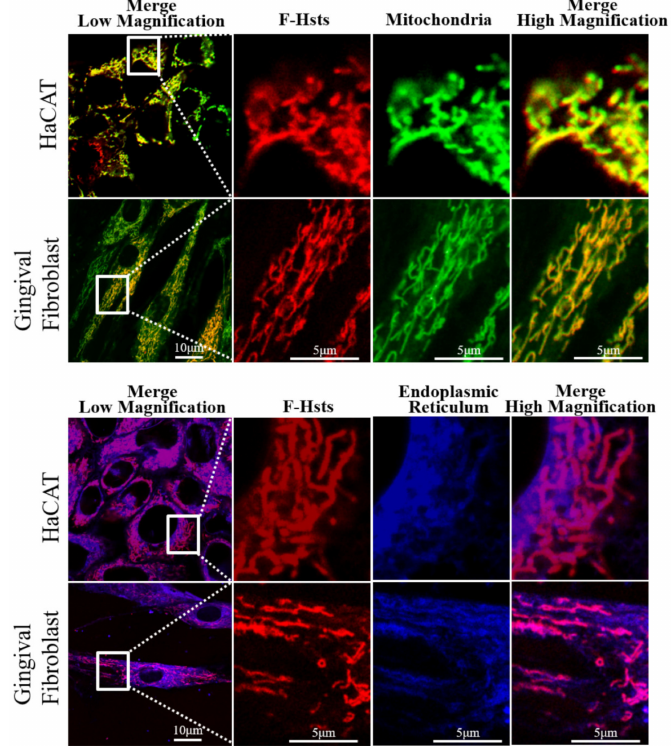
Figure 6. CLSM images showed that F-Hst1 (in red) was also targeted to mitochondria (in green) and endoplasmic reticulum (ER) (in blue) in both HaCaT epithelial cell line and primary human gingival fibroblasts as in HO1N1 epithelial